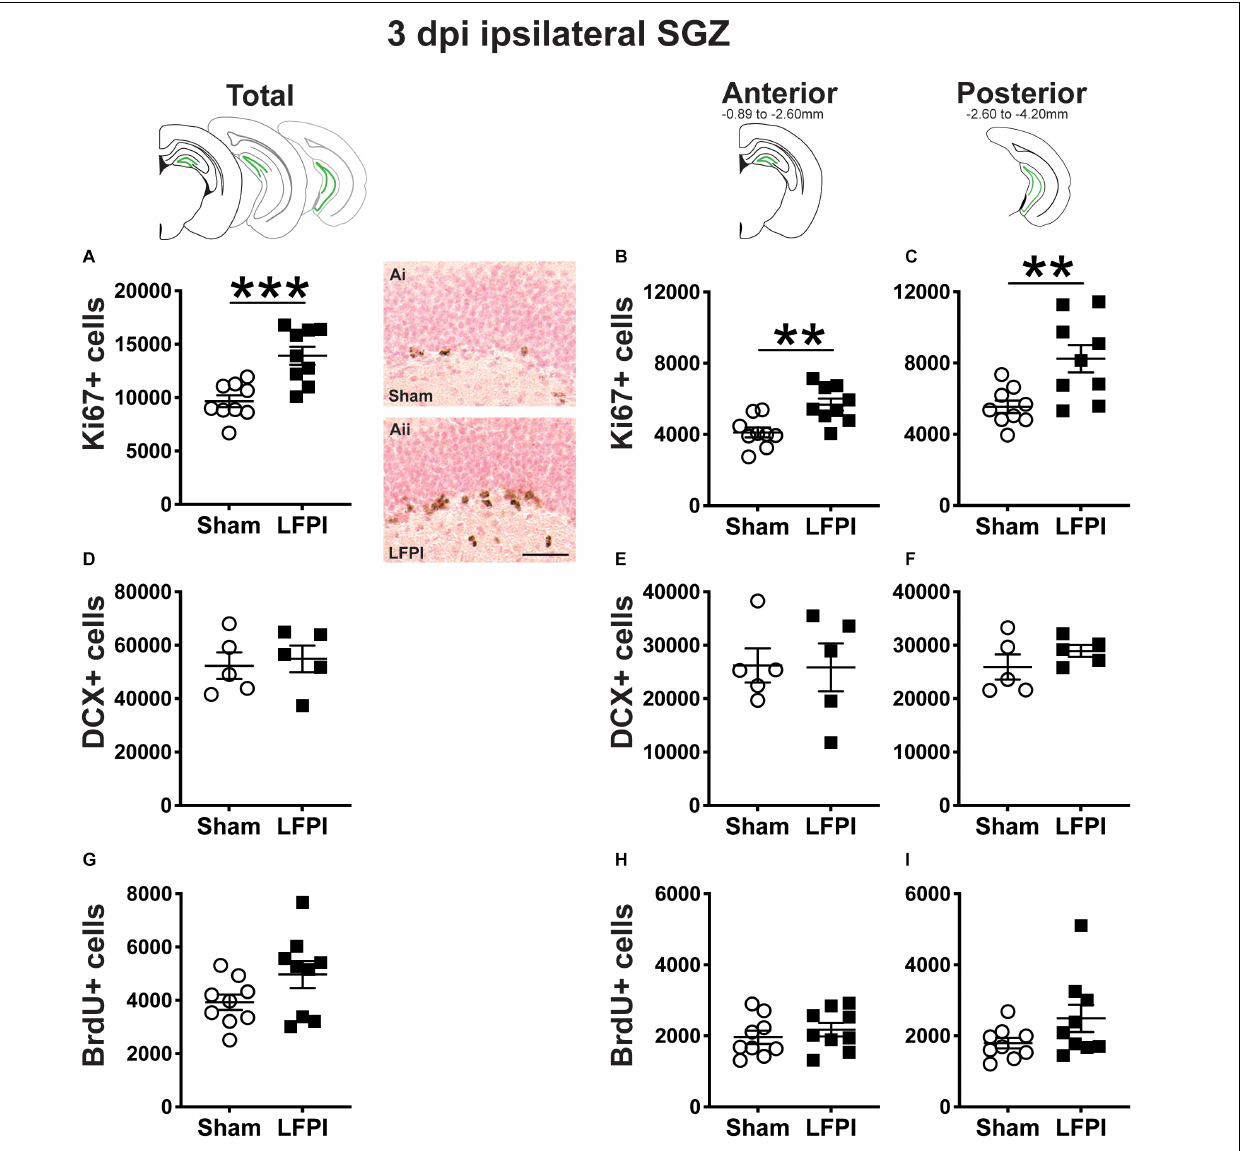
FIGURE 2 | Relative to Sham, LFPI increases the number of Ki67-immunoreactive (Ki67+) proliferating cells in the ipsilateral mouse subgranular zone (SGZ) 3 dpi. As in Figure 1D , green lines in schematics (top row) indicate the ipsilateral SGZ/GCL. Stereological quantification of Ki67+ (A–C ; Sham n = 9, LFPI n = 9 ) , DCX+ (D–F ; Sham n = 5, LFPI n = 5), and BrdU+ (G–I ; Sham n = 9, LFPI n = 9 ) cells in the SGZ (Ki67, BrdU) and SGZ/GCL (DCX). Immunopositive cells were quantified considering immunopositive cells in the SGZ across the entire longitudinal axis (see sample representative schematics above A,D,G ), and also divided into anterior DG (see sample schematic above B,E,H ) and posterior DG (see sample schematic above C,F,I ), operationally defined as Bregma levels − 0.92 to − 2.6; and − 2.6 to − 3.97, respectively. Representative photomicrographs of Sham (Ai) and LFPI (Aii) Ki67-stained tissue are shown alongside quantification of total Ki67+ cells. Scale bar = 50 µ m. T-test, ** p < 0.01 and *** p <